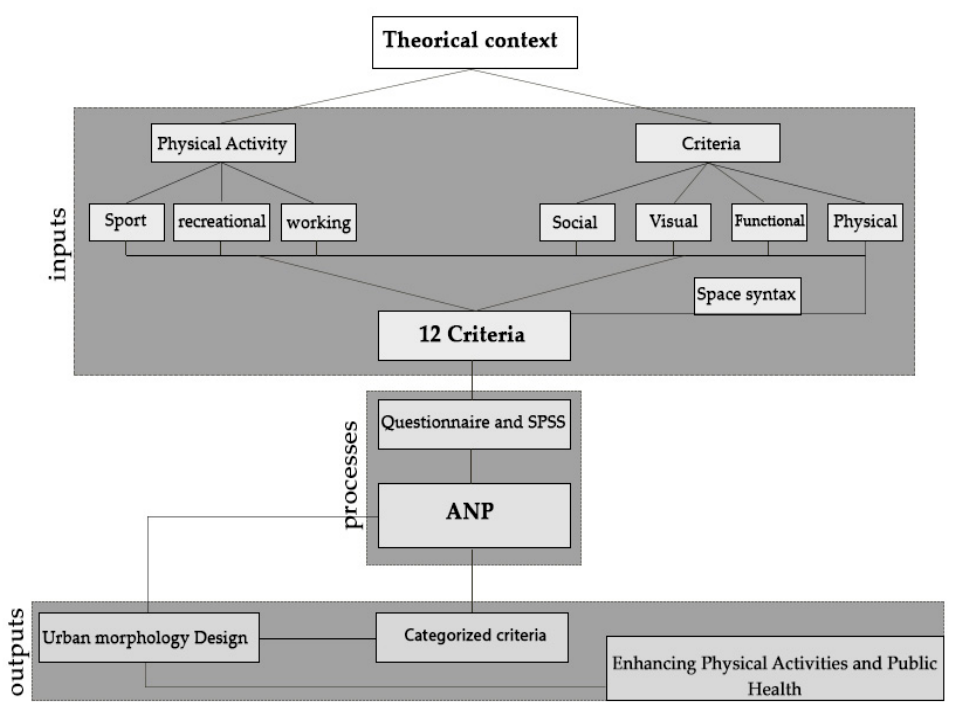
Figure 3. Different steps of the study. Figure 3. Di ff erent steps of the